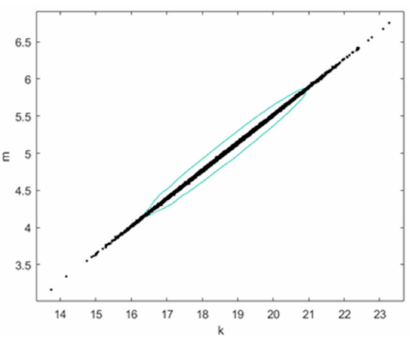
Figure 4. Correlation between k and m